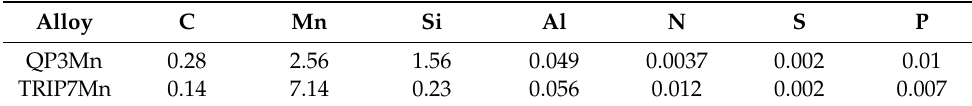
Table 1. Sheet steel chemical compositions